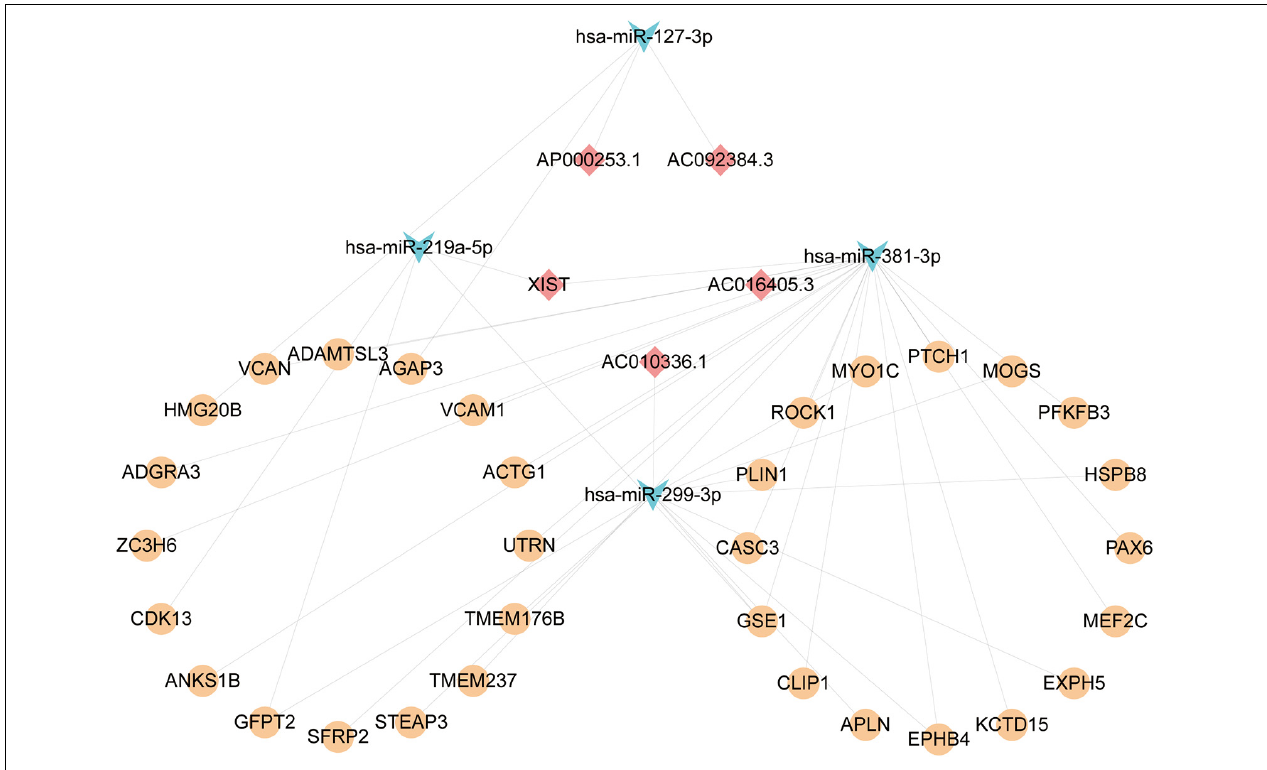
FIGURE 4 | The Up lncRNA-miRNA-mRNA ceRNA network. Squares represent DElncRNAs, whereas triangles represent DEmiRNAs, and circles represent DEmRNAs. Light blue indicates down-regulated DEmiRNAs. Light red represents Down-regulated DElncRNAs. Orange-yellow indicates up-regulated